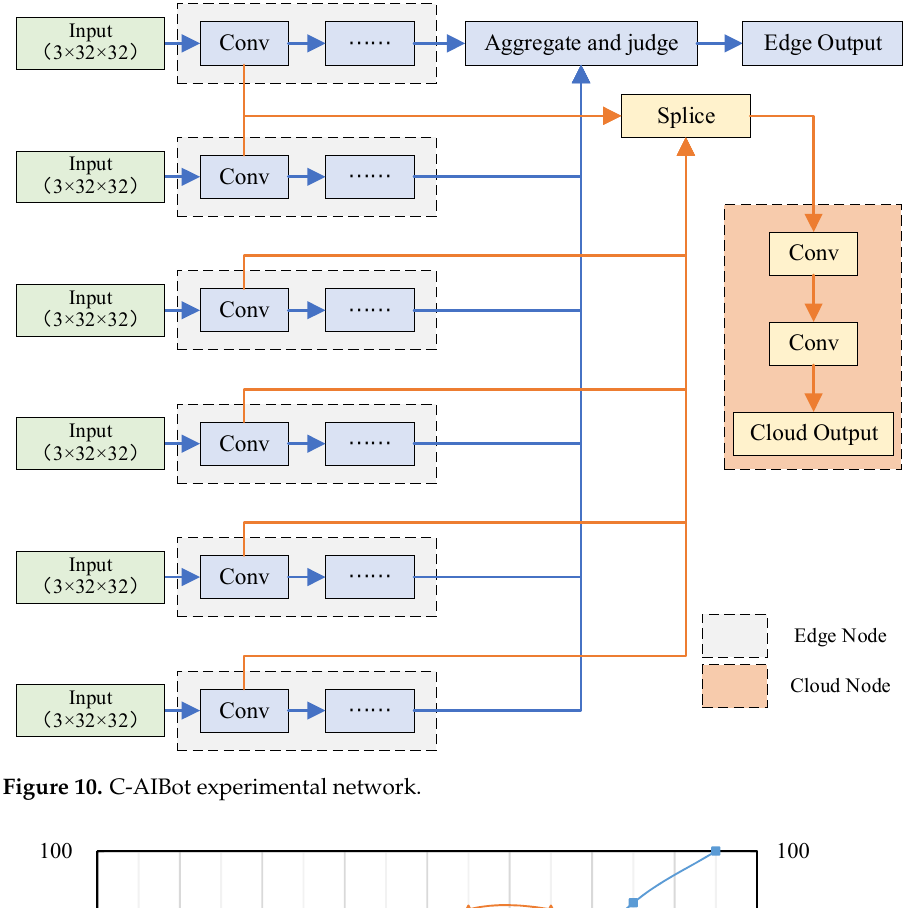
Figure 10. C-AIBot experimental network.